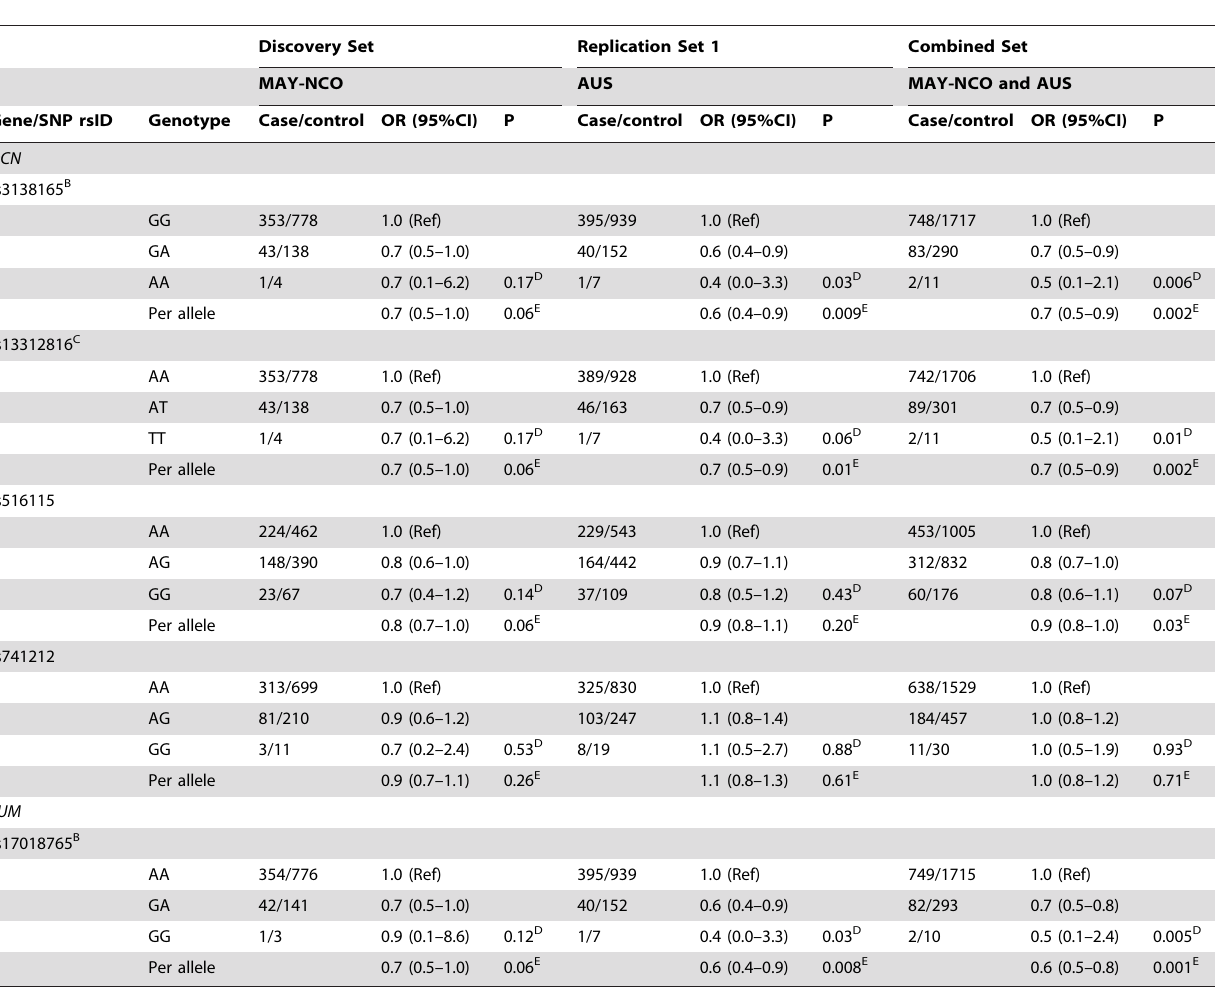
Table 2. Odds ratios (OR) and 95% confidence intervals (CI) A between variants in DCN and LUM genes and serous epithelial ovarian cancer